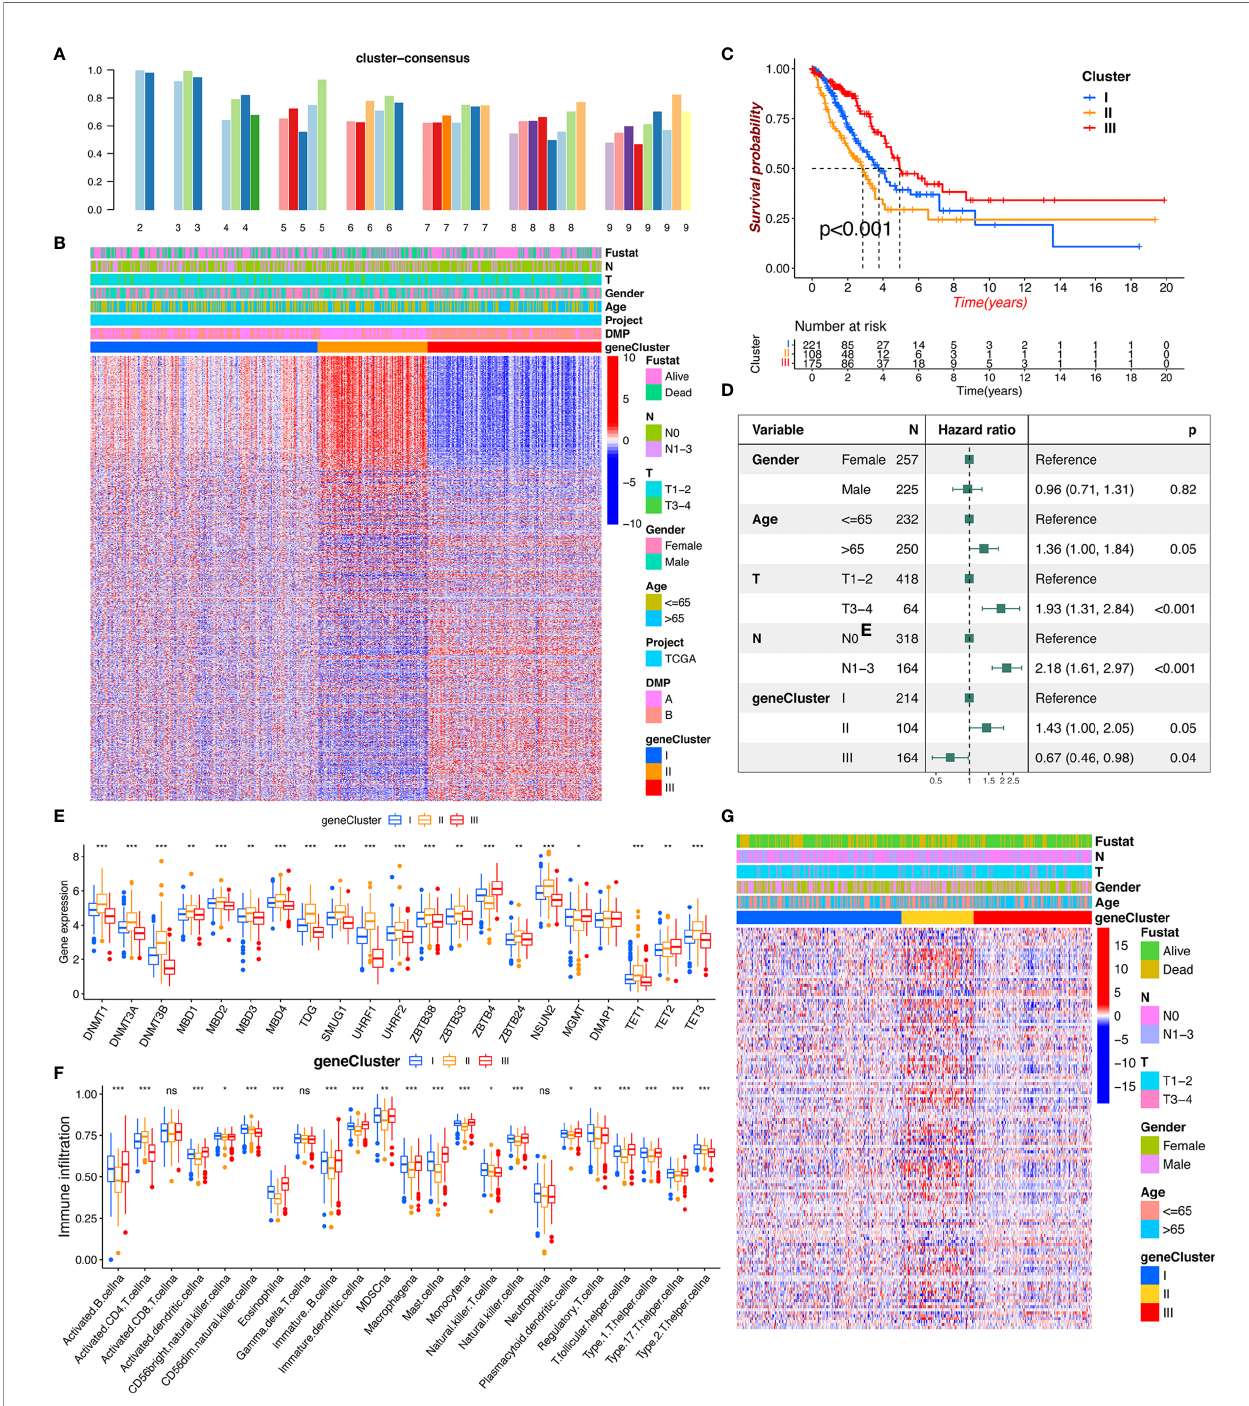
FIGURE 4 | DMP phenotype-related DEGs and the clinical characterization of gene clusters. (A) Cluster-consensus (CLC) plot of unsupervised clustering showed the consensus scores of subcluster at each ( k ) (B) Unsupervised clustering of 586 DNA methylation-related genes in the TCGA LUAD cohort classifying patients into three distinct subclusters, renamed as gene cluster I/II/III, respectively. The clinical annotation information including survival state, tumor stage, sex, age, and DMP cluster, as well as gene cluster were enrolled. (C) Kaplan-Meier plotter estimated the survival outcome of the different gene clusters. (D) Multiple Cox regression analysis estimated the clinical prognostic value between gene clusters in the TCGA cohort. The length of the horizontal line represents the 95% con fi dence interval for each group. (E) The expression level of 21 regulators in distinct gene clusters. (F) The immune cell in fi ltration fraction in three gene clusters using the ssGSEA algorithm. The asterisks represented as the statistically signi fi cant p -values: * p < 0.05, ** p < 0.01, *** p < 0.001. (G) The heatmap analysis of DNA methylation status evaluation for each gene cluster. ns, no signi fi cance.